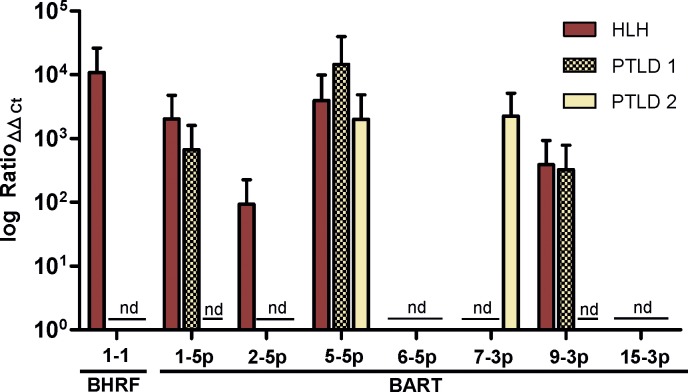
Comparison of the expression profiles of an HLH sample and two PTLD samples.Samples were collected from one patient with haemophagocytic lymphohistiocytosis (HLH) and two patients with post-transplant lymphoproliferative disorder (PTLD) and separately analysed. Expression levels were calculated by the efficiency-corrected ΔΔCt method.